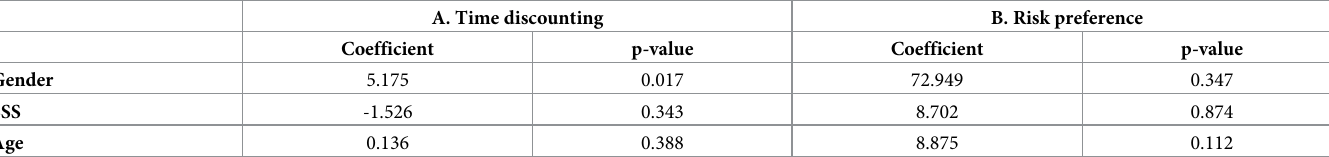
Table 3. LNAM regressions of time discounting and risk preference.